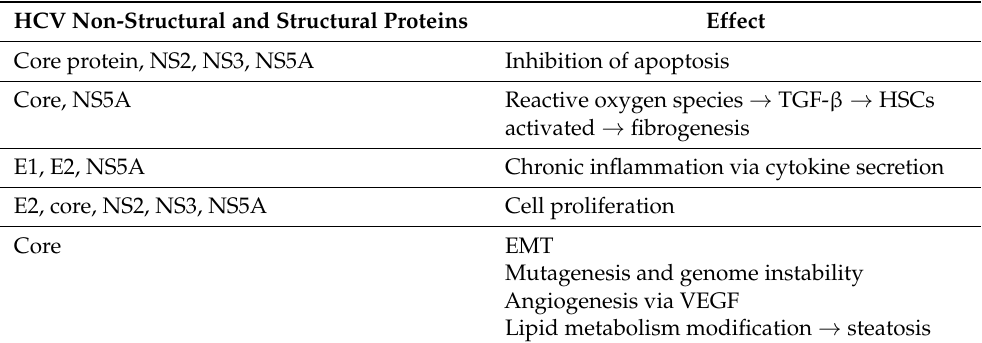
Table 1. Overview of HCV components that induce hepatic